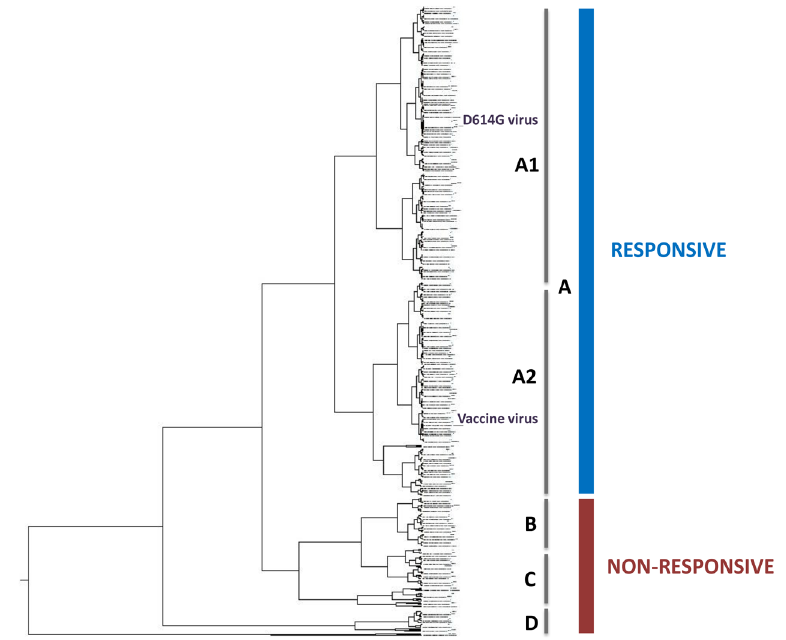
Figure 2. The ISM-based phylogenetic tree of the non-redundant SP1 proteins from SARS-CoV-2 viruses deposited in GISAID from January to October 2020.